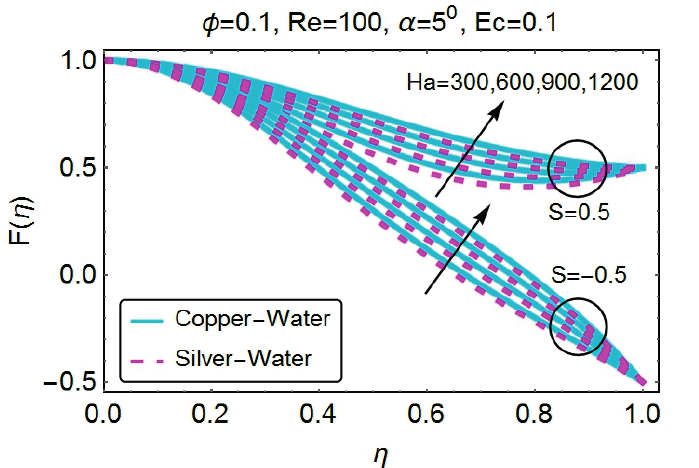
Figure 6. Change in velocity for varying Ha (divergent